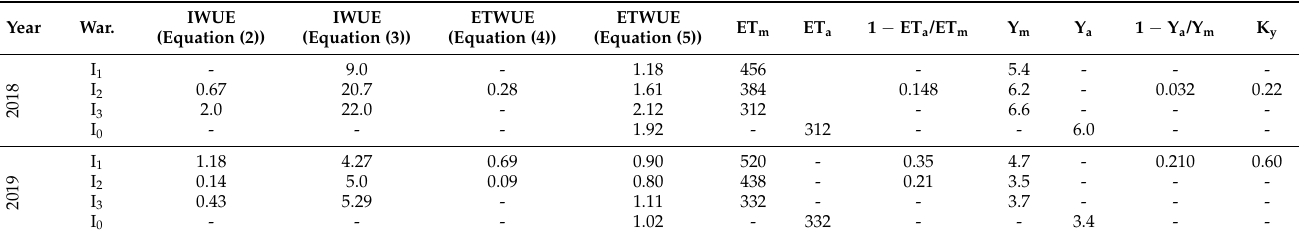
Table 7. Irrigation water use efficiency (IWUE), evapotranspiration water use efficiency (ETWUE), and yield response factor (K y ) of fiber